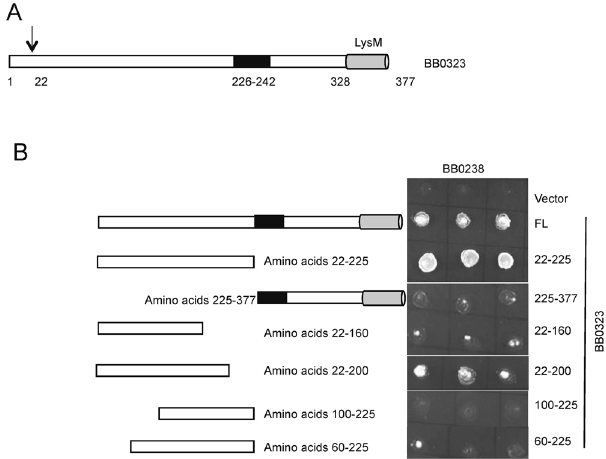
Figure 2. BB0238 interaction region in BB0323 encompasses the 200 N-terminal amino acids. ( A ) Schematic representation of full-length BB0323. Arrow indicates the predicted signal peptide cleavage site. Residues 226–242 indicate the interaction region between the N- and C-terminal BB0323 polypeptides 17 . ( B ) Yeast two-hybrid assays to identify the BB0238-BB0323 interaction region. Truncated BB0323 fusion proteins, as schematically represented (left panels) were expressed in yeast as BD-BB0323 fusion proteins that were cotransformed with AD-BB0238 and yeast growth was monitored as detailed in Fig.